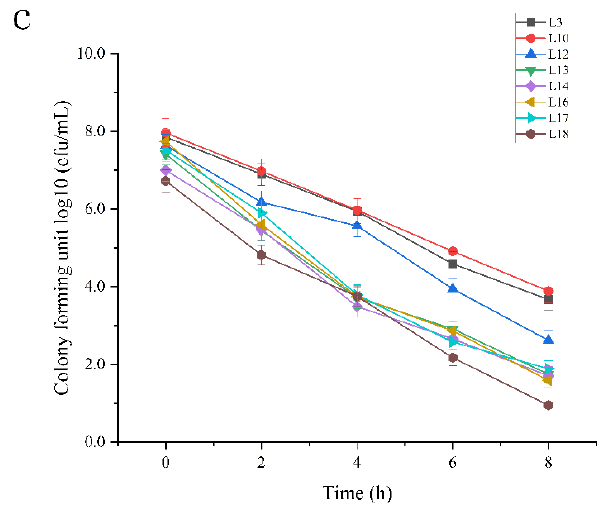
Figure 2. Viable numbers [Log 10 CFU/mL] of selected 8 strains after being cultured with H 2 O 2 for different times. The initial cell concentration of 8 strains was 10 10 CFU/mL in ( a ), 10 9 CFU/mL in ( b ) and 10 8 CFU/mL in ( c ), respectively.